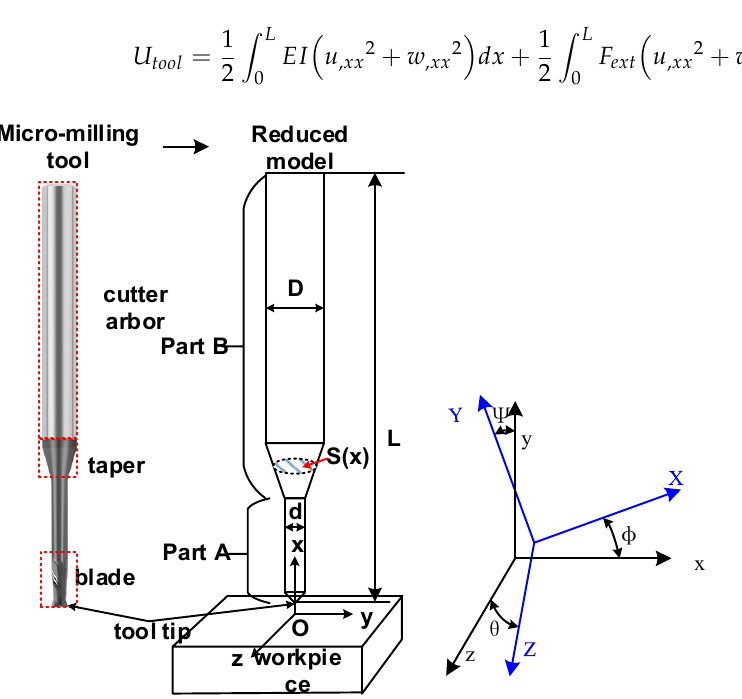
Figure 2. Typical micro-milling tool